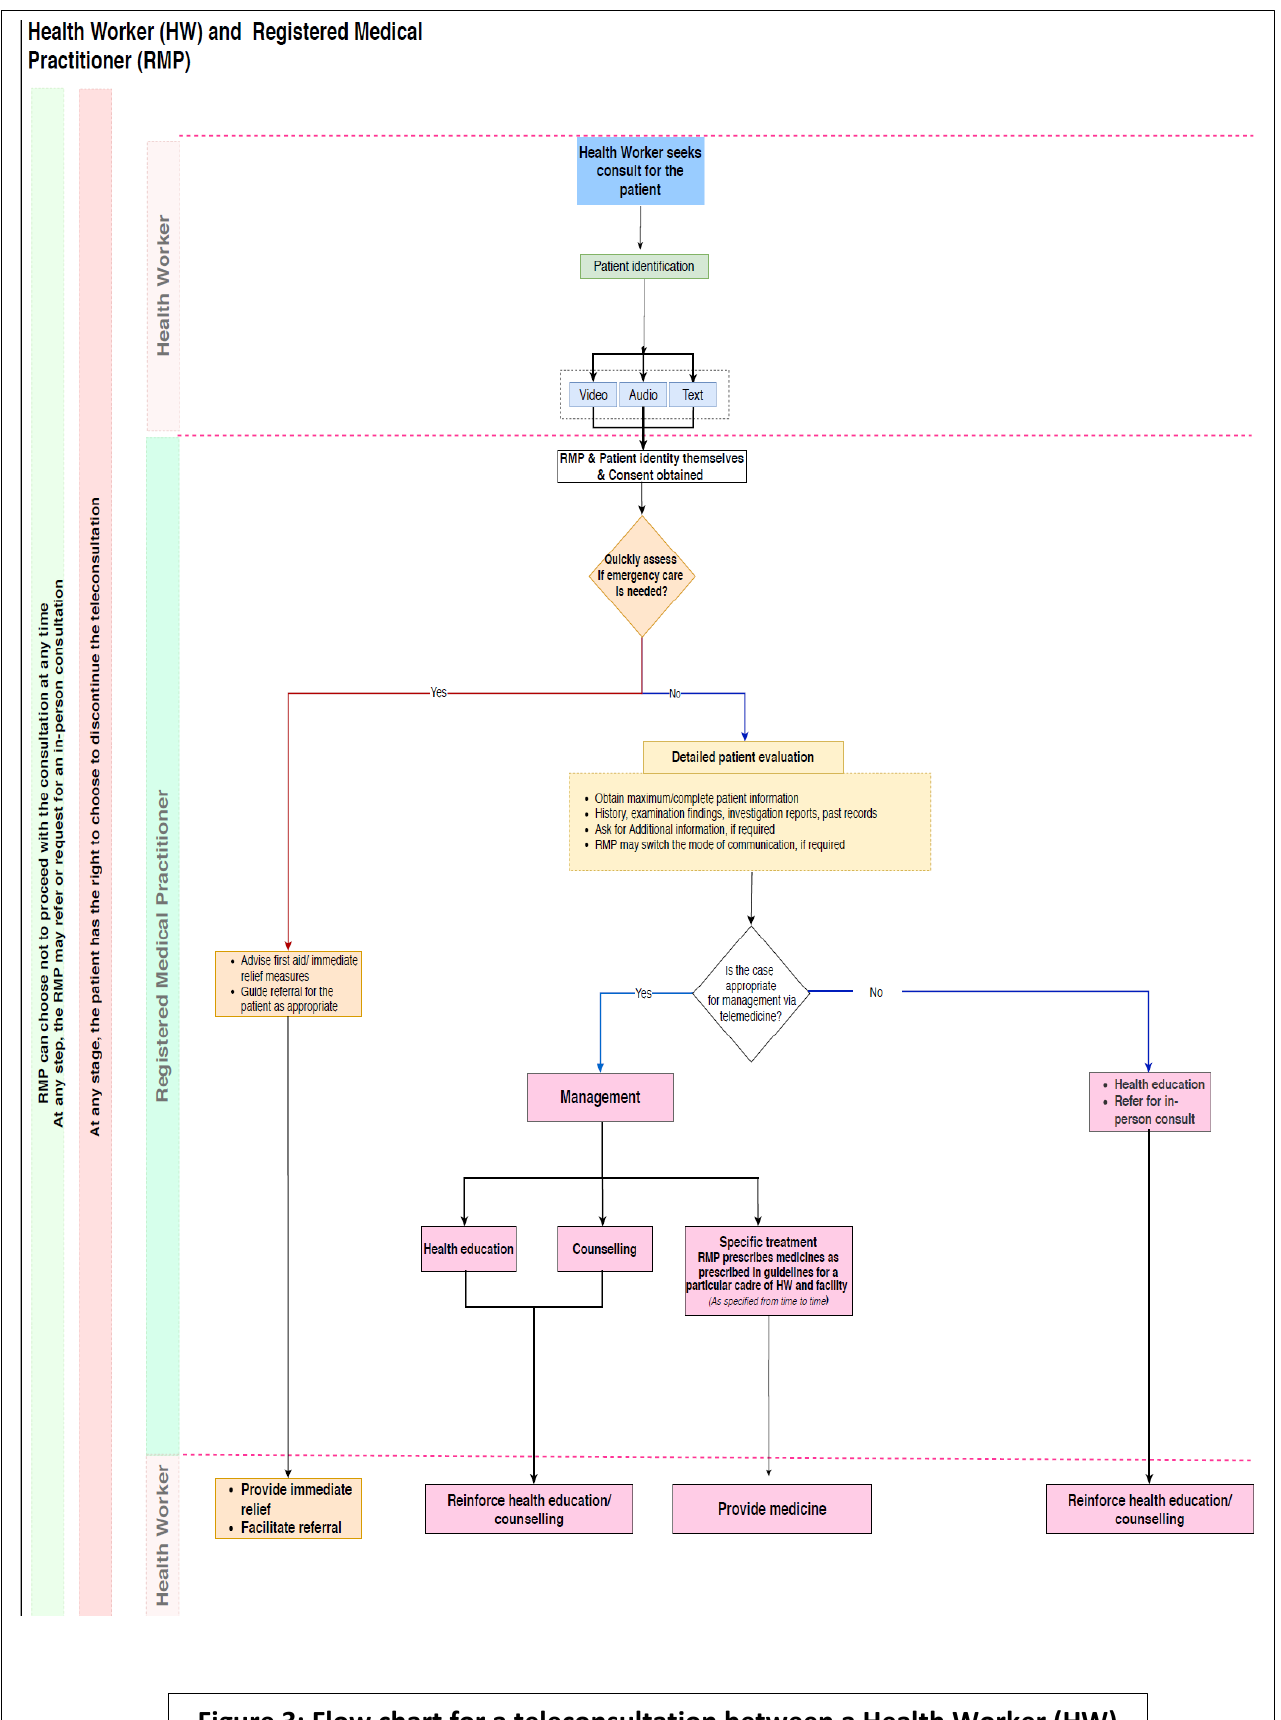
Figure 3: Flow chart for a teleconsultation between a Health Worker (HW) and a Registered Medical